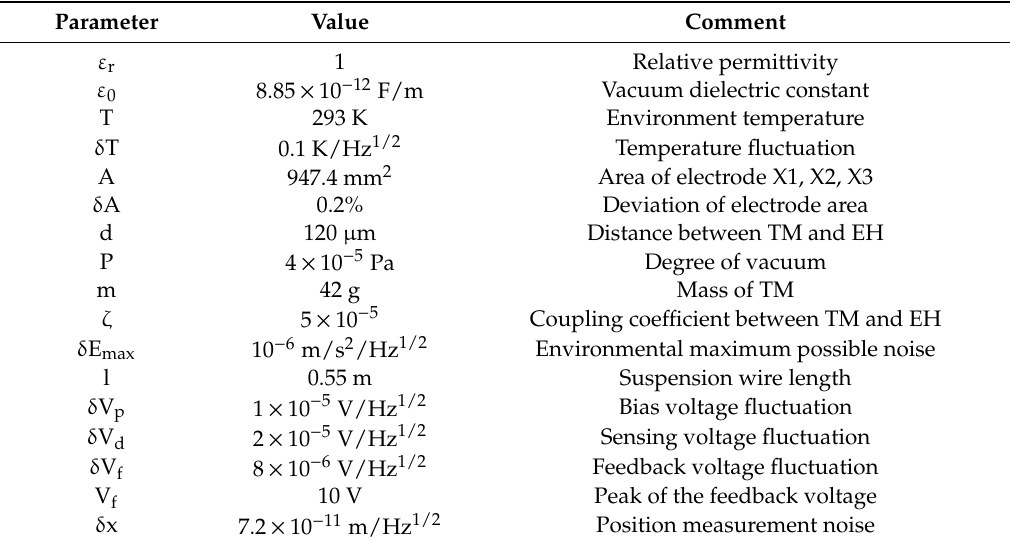
Table 4. Related parameters